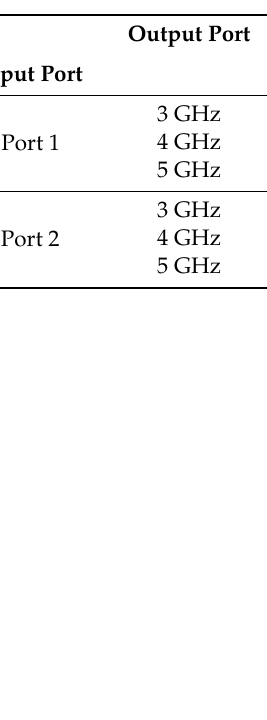
Table 3. Measurement results of phase di ff erence for 4 × 4 Butler matrix.